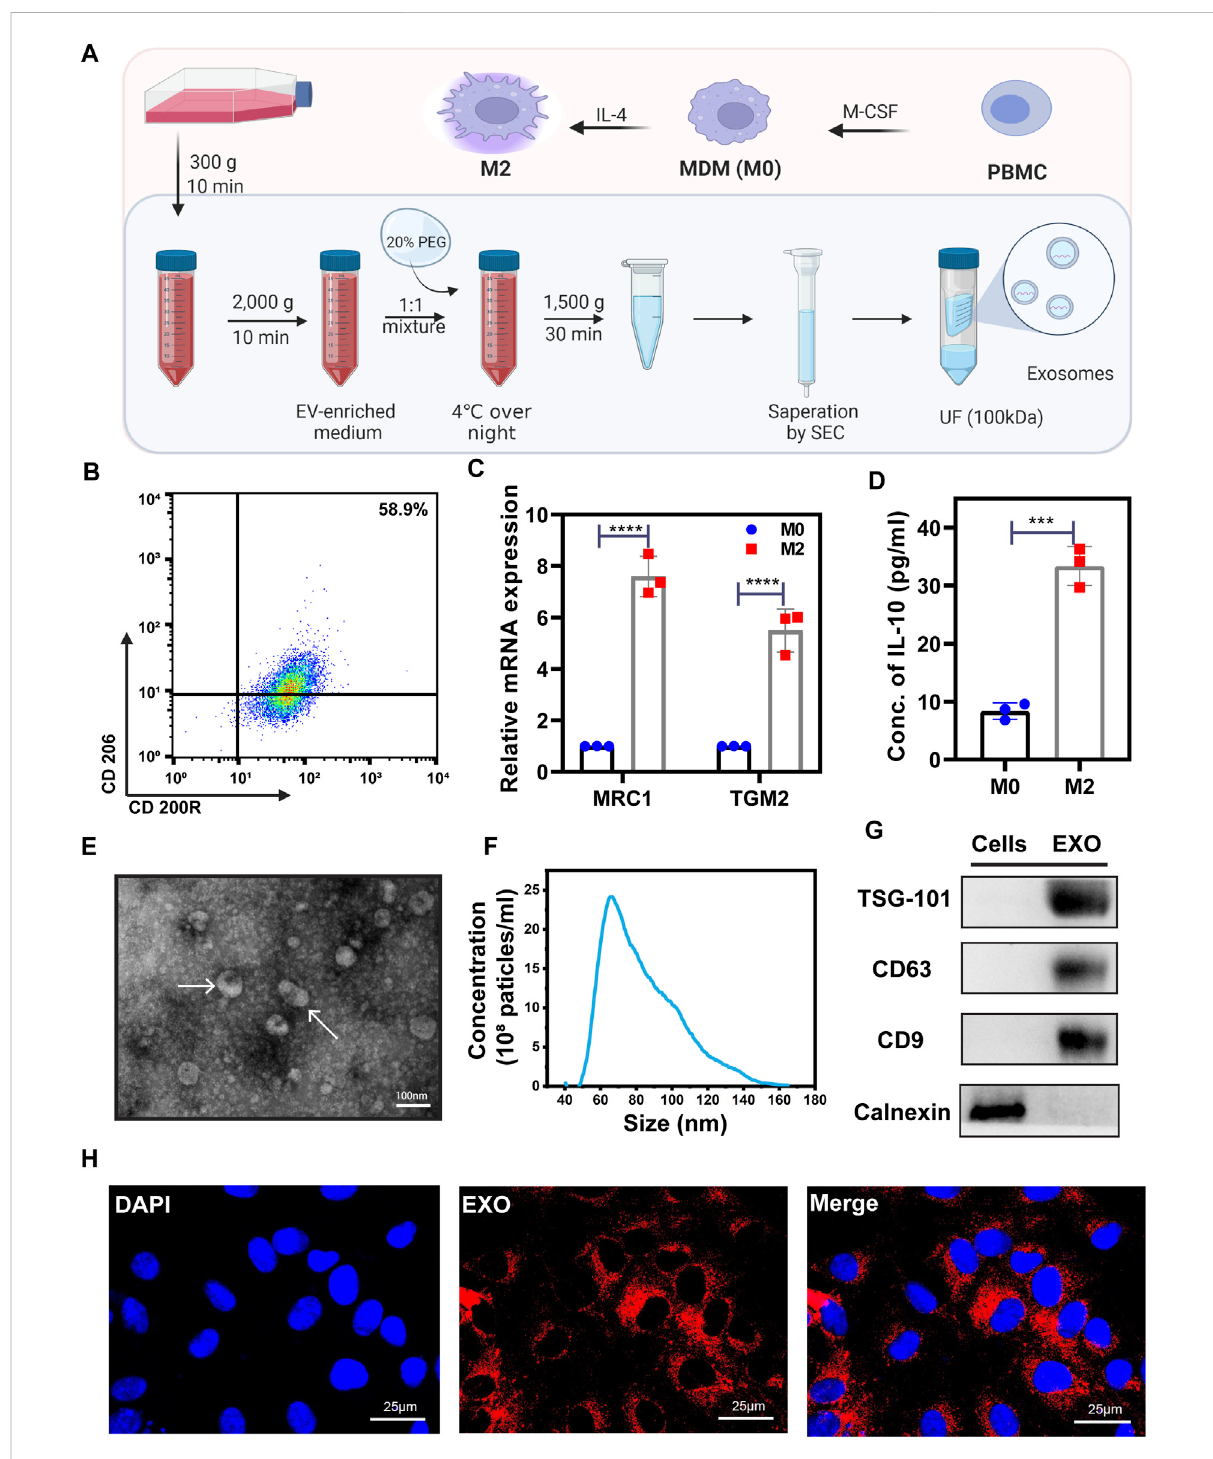
FIGURE 1 The characterization of M2 and exosome derived from M2. (A) Schematic of PEG precipitation exosome extraction fl ow. A detailed description wasshownintheMethodspart.CreatedwithBioRender.com. (B) FlowcytometryscatterplotsofM2representativesurfacebiomarkersCD200Rand CD206 expression level. With a 58.9% CD200R+/CD206+ expression level, these cells were veri fi ed as M2 cells. (C) qRT-PCR was used to test the expression levels of M2 markers, MRC1, and TGM2. (D) ELISA kit was used to test the concentration of IL-10 in the M0 and M2 cell culture medium. (E) TEM image of extracted exosomes. Exosomes were labeled by white arrows. (F) Nanoparticle Tracking Analysis (NTA) of exosomes. (G) Western blot was used to test exosome biomarkers expression. With a higher expression of TSG-101, CD63, CD9, and lower expression of Calnexin compared with normal cells, the extracted vesicles are veri fi ed as exosomes. (H) Representative immuno fl uorescence images of PKH26- labeled M2-EXO (red) internalized into HUVECs. Scale bar was shown in the images. Data was expressed as mean ± 3 σ (n = 3); * = signi fi cant, * p < 0. 05; ** p < 0.01,*** p < 0.005; **** p < 0.001, Student t